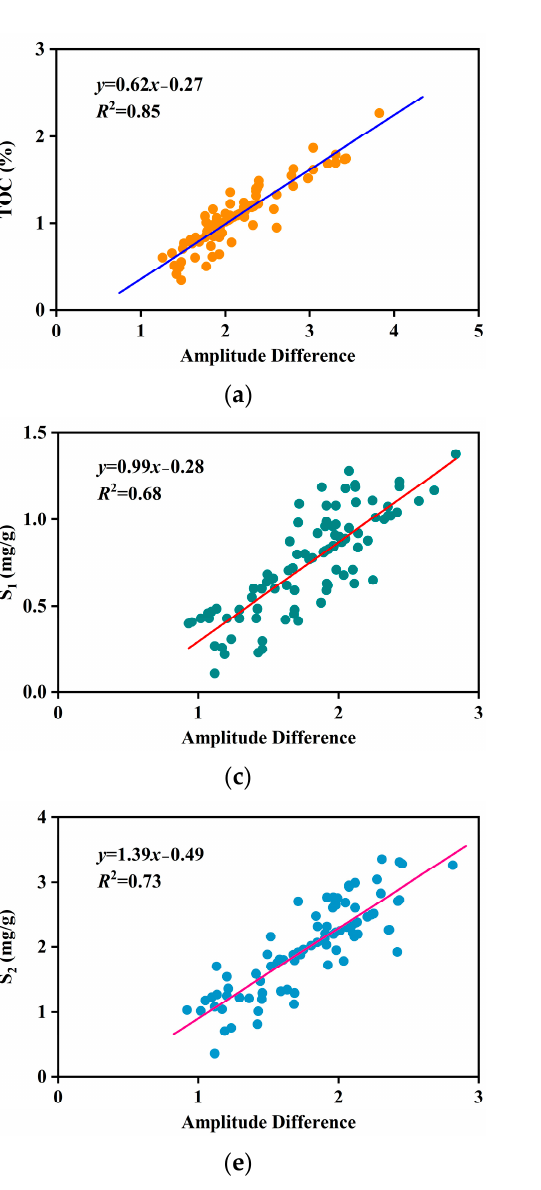
Figure 7. Relationships between calculated and measured TOC , S 1 , and S 2 ( b , d , f ). Relationship between amplitude difference and TOC , S 1 , and S 2 ( a , c , e ).